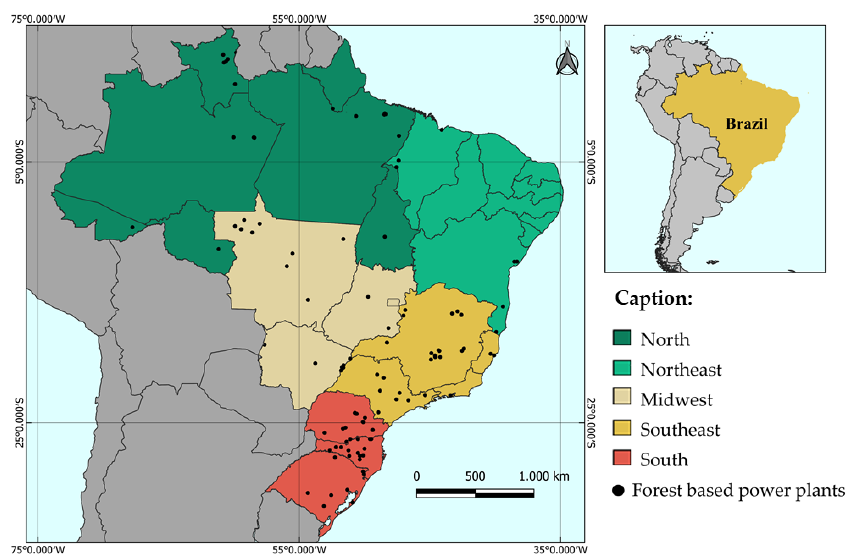
Figure 1. The spatial distribution of forest-based power plants in Brazil regions, in 2019. Source: [28].